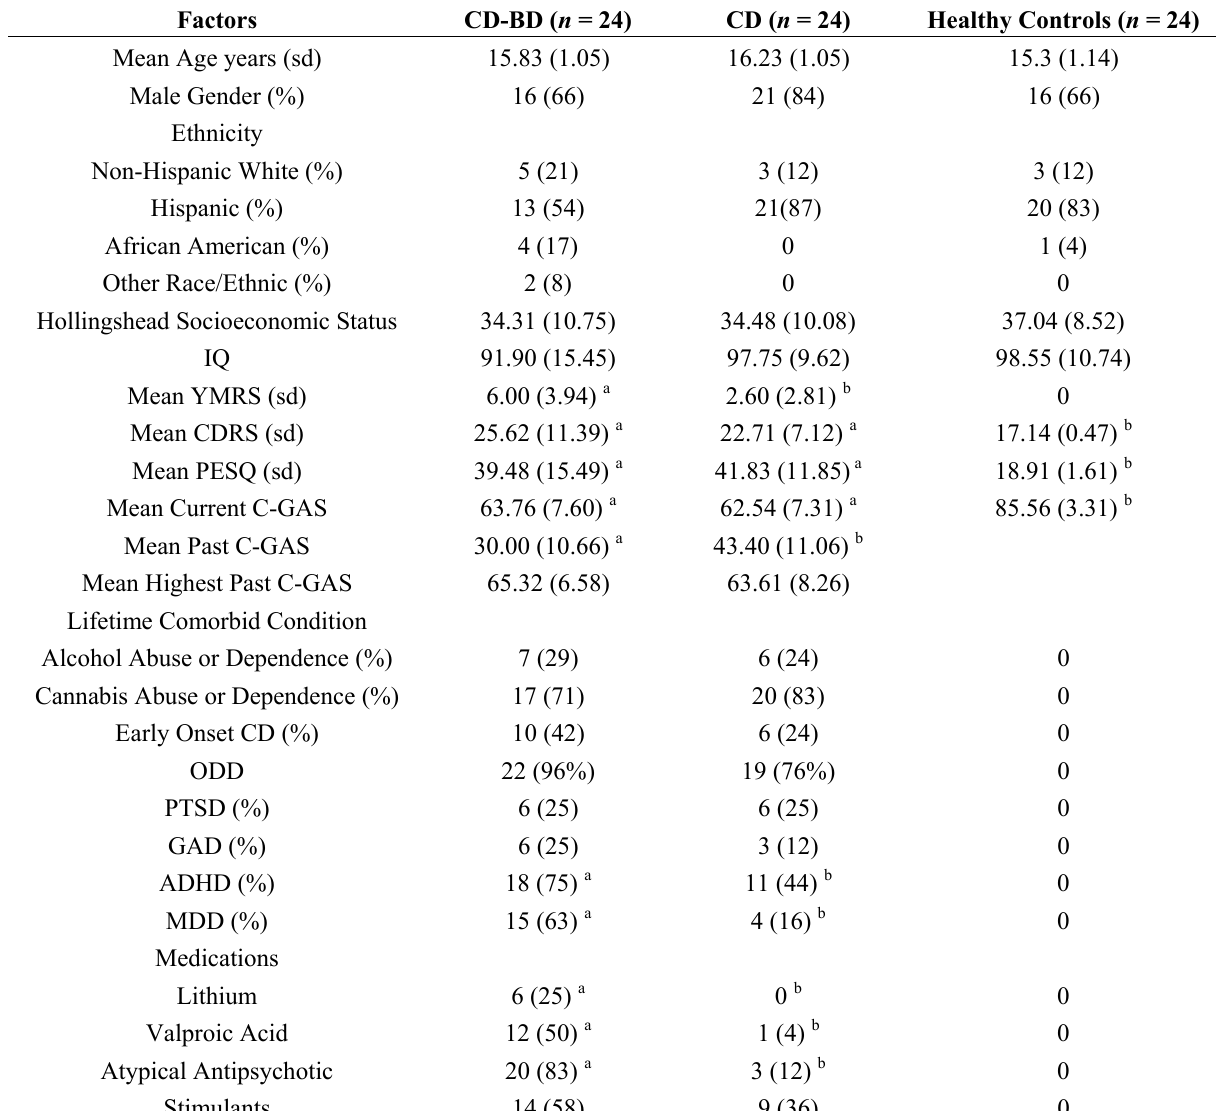
Table 1. Demographic and clinical